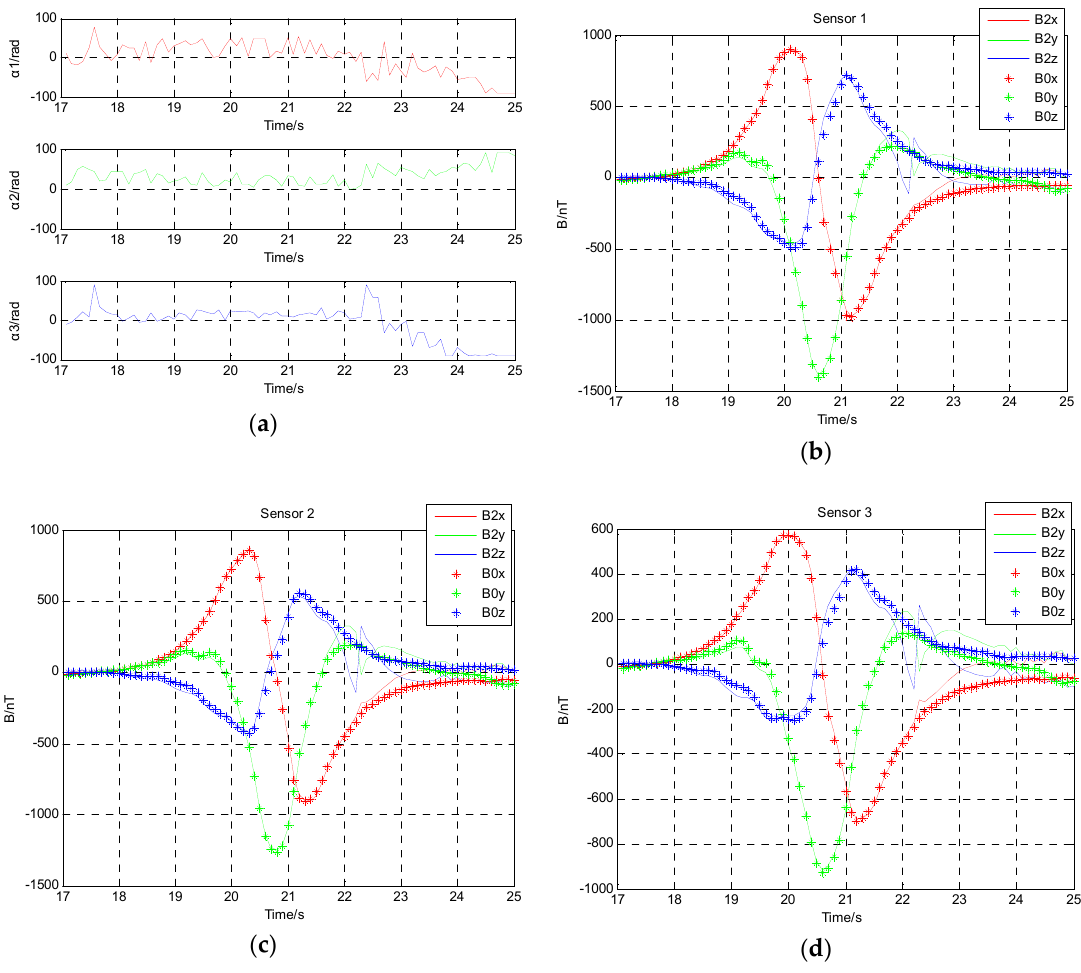
Figure 20. ( a ) The rotation angle between the moving ferromagnetic target and the magnetic sensor; ( b ) Contrast of the magnetic field calibrated by angular data and the actual magnetic field without angular rotation acquired by magnetic sensor 1; ( c ) Contrast of the magnetic field calibrated by angular data and the actual magnetic field without angular rotation acquired by magnetic sensor 2; ( d ) Contrast of the magnetic field calibrated by angular data and the actual magnetic field without angular rotation acquired by magnetic sensor 3.